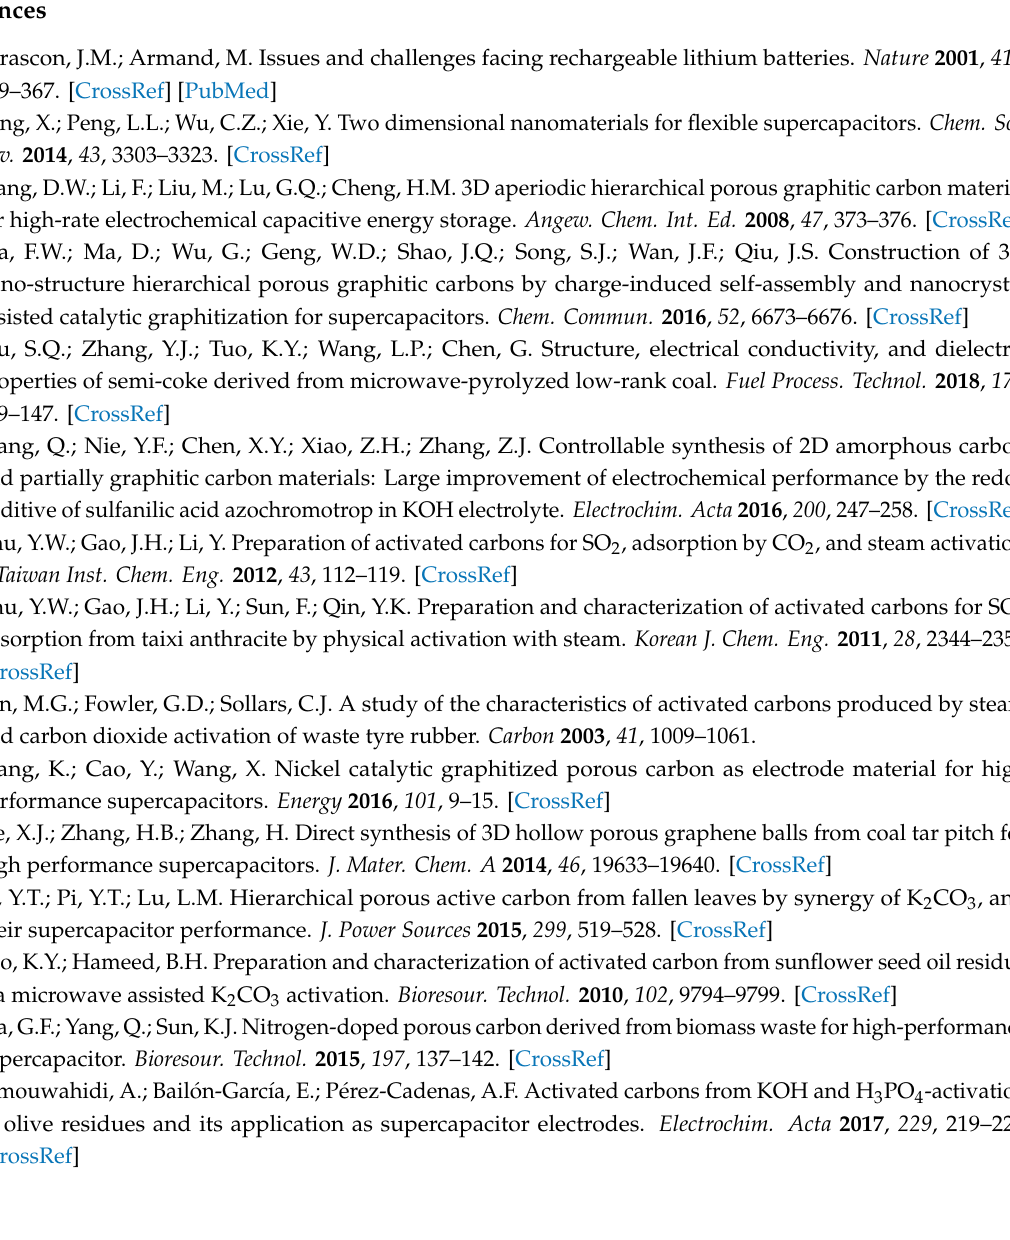
Figure S1: XRD profiles of the (a) raw Huolinhe lignite and (b) demineralized sample, Figure S2: XRD phase analysis of C-1FeHLH-5 and C-1FeHLH-5(H), Figure S3: XRD profiles from di ff erent AC during